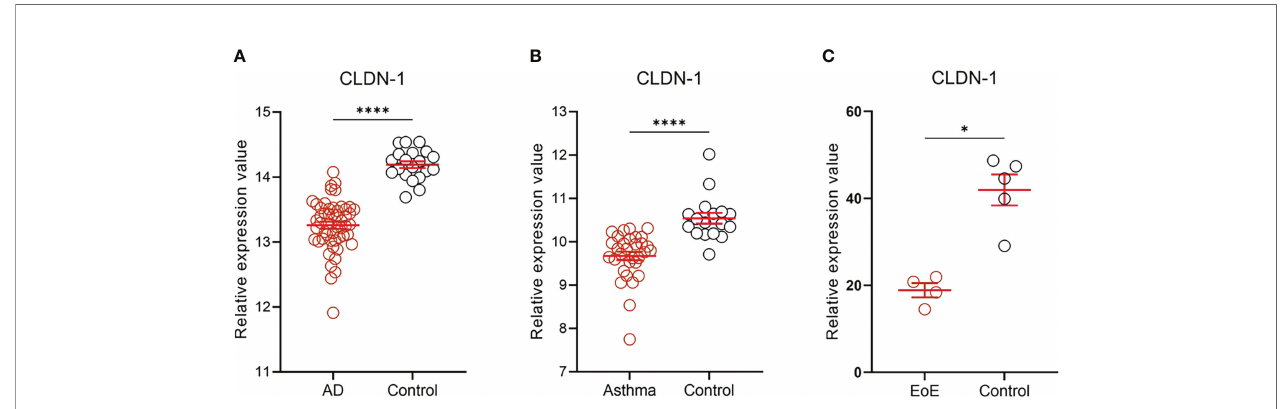
FIGURE 2 | CLDN-1 expression level in the epithelial tissue of patients with allergic diseases. CLDN-1 expression level was downregulated in the epithelium of skin, airways, and GI tract in patients with AD, asthma, and EoE, respectively. (A) CLDN-1 mRNA expression in lesional skin of AD patients (n=52) and healthy controls (n = 20). (B) CLDN-1 mRNA expression in bronchial epithelium of patients with severe asthma (n = 31) and healthy controls (n = 17). (C) CLDN-1 mRNA expression in esophageal epithelium of patients with EoE (n = 4) and healthy controls (n = 5). * P < 0.05; **** P < 0.0001 by Mann-Whitney U test. Error bars indicate SEM. AD, atopic dermatitis; EoE, eosinophilic